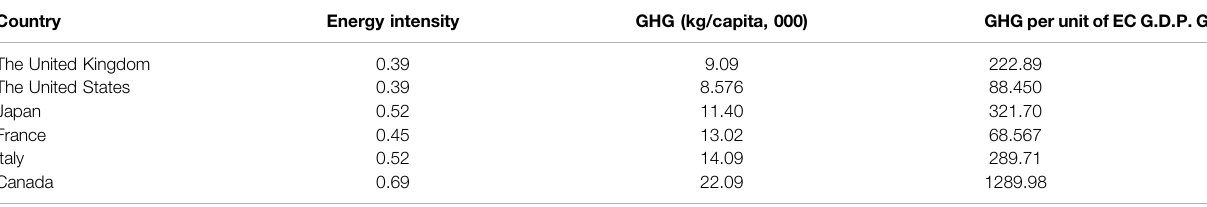
TABLE 2 | Average score of individual indicators. Country Energy intensity GHG (kg/capita, 000) GHG per unit ofEC G.D.P.Growth